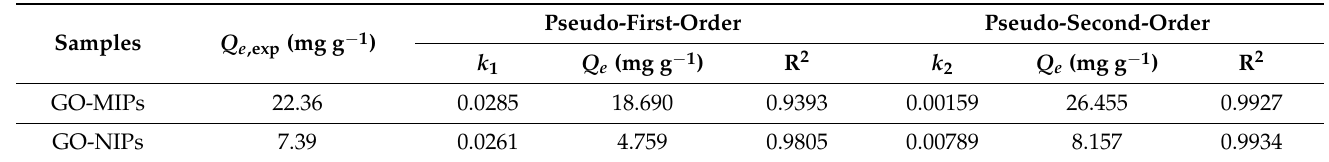
Table 1. Kinetic constants of the pseudo-first-order equation and pseudo-second-order equation for 4-MEC on GO-MIPs and GO-NIPs.